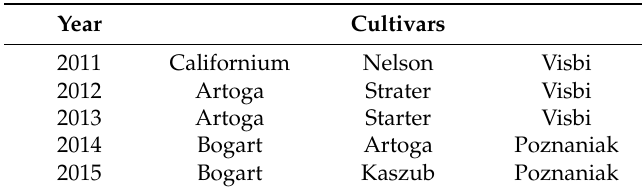
Table 3. Cultivars used in the experiments aimed at model